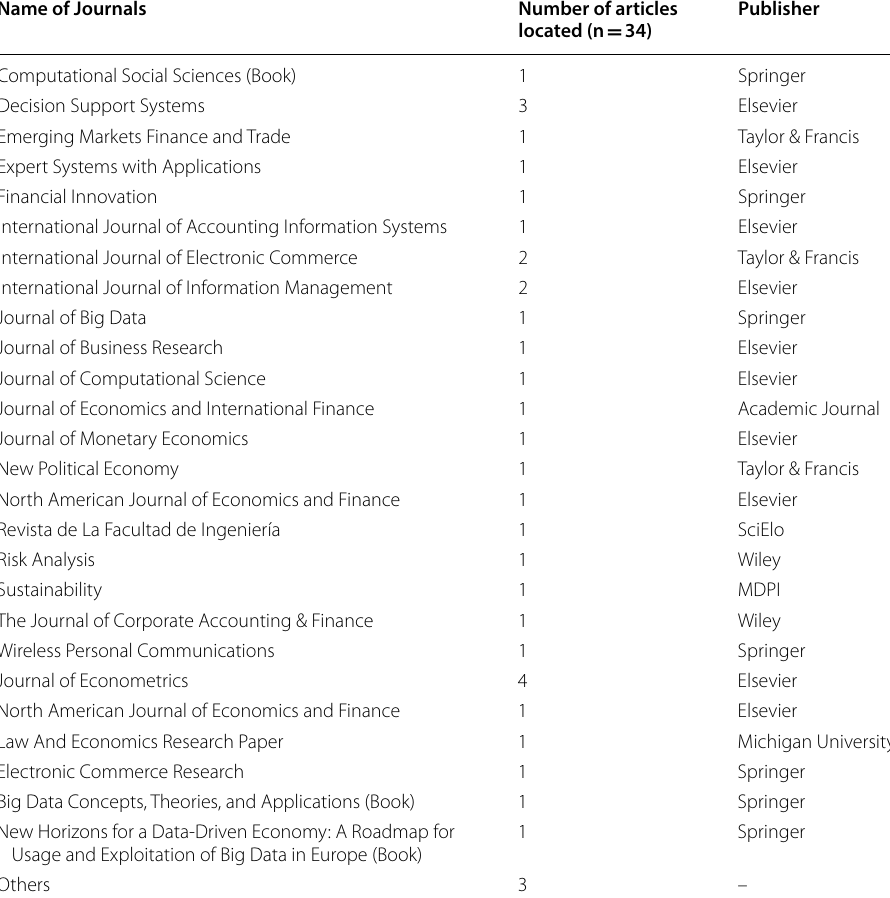
Table 1 List of journals publish research related to big data and finance. Source: Author’s